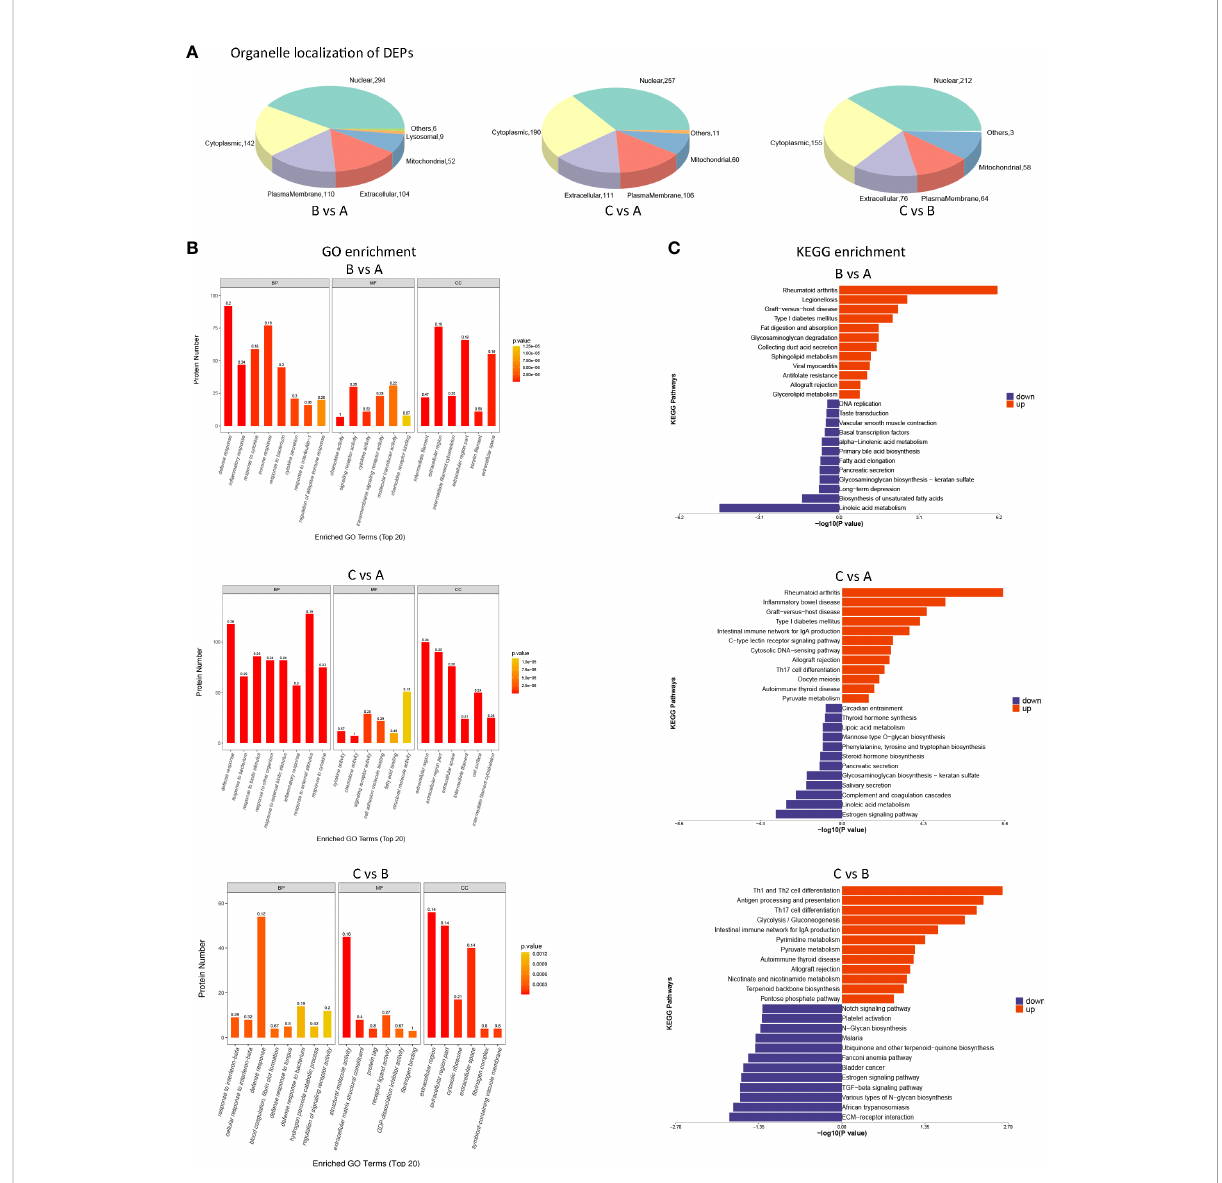
FIGURE 6 Biological analysis of differentially expressed proteins (DEPs) between different groups (A) Pie chart of organelle localization of DEPs. eSubcellular localization prediction was performed using the method of CELLO (http://cello.life.nctu.edu.tw/). At the same time, the number and distribution ratio of proteins in each subcellular organelle are displayed in the form of a pie chart. (B) GO enrichment analysis of DEPs. Blast2GO was used to annotate target protein collections with GO annotations. GO enrichment fi ndings of DEPs were classi fi ed as molecular function (MF), biological process (BP), and cellular component (CC). (C) KEGG pathway annotation statistics of DEPs (Top20). KEGG Automated Annotation Server (KAAS) was used to execute KEGG pathway annotation on target protein